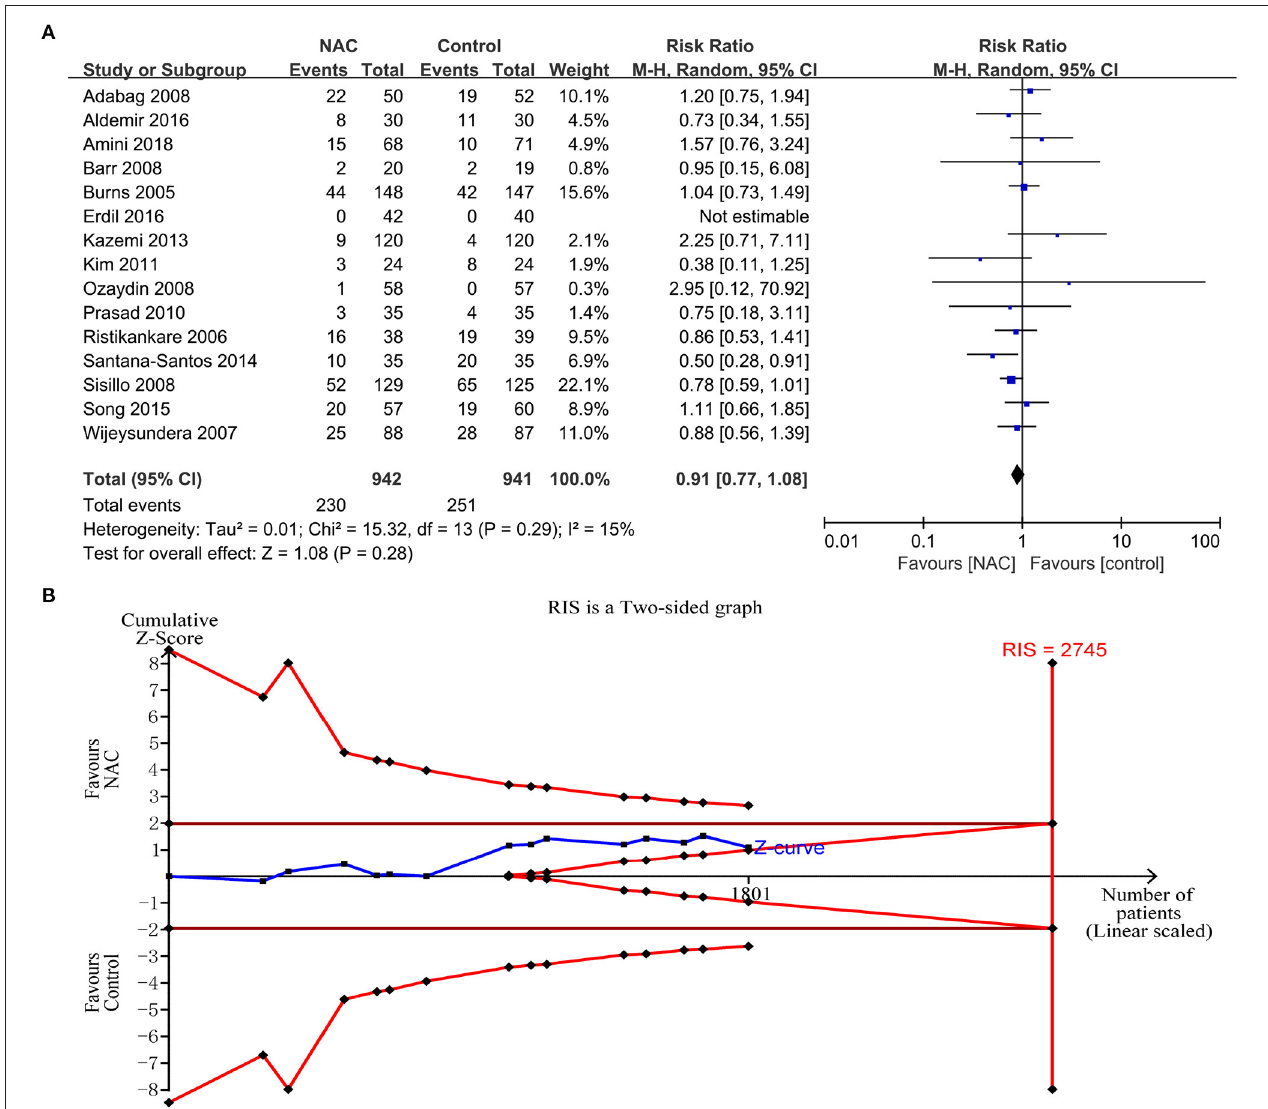
FIGURE 3 | The effects of NAC on the incidence of AKI. (A) Forest plot of the incidence of AKI between NAC and controlled groups. (B) Fixed effects model of the TSA of the incidence of AKI between NAC and controlled groups. A diversity-adjusted information size of 2,745 participants was calculated based on a control event rate of 26.7% and a RR reduction of 20%, with α = 5% (two-sided), β = 20%, and I 2 = 15%. The solid blue line represents the cumulative Z-curve, which did not cross the conventional boundary (solid dark red line), the trial sequential monitoring boundary (solid red line), and the futility boundary (solid red